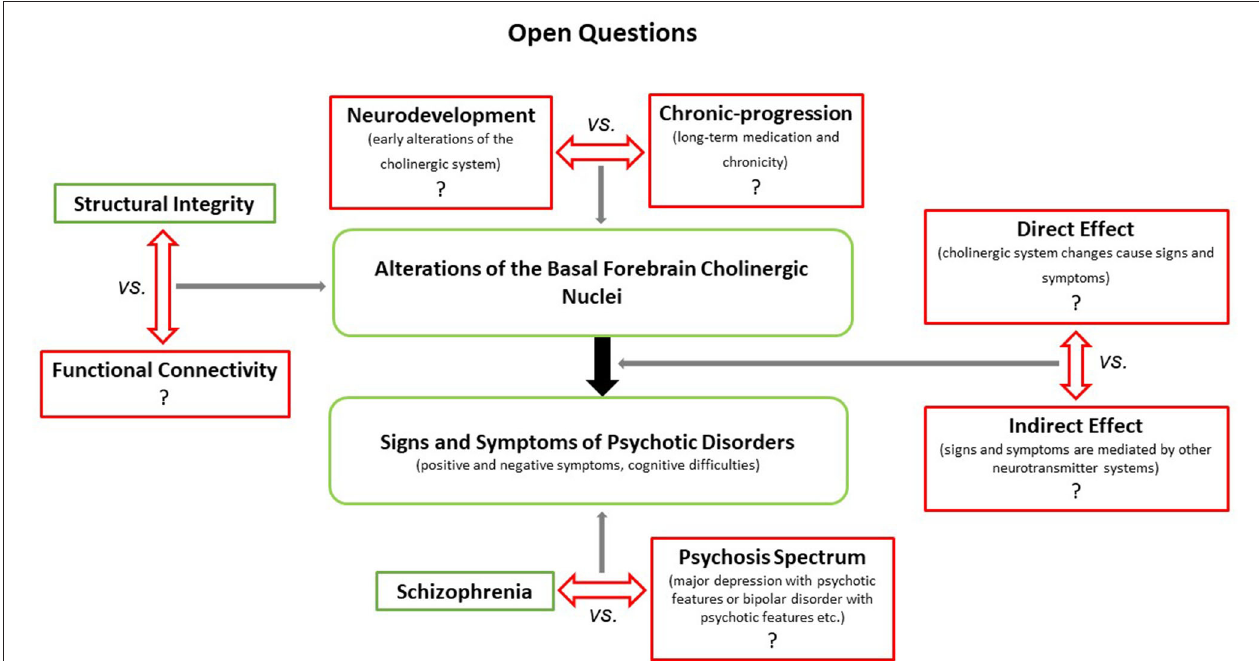
FIGURE 1 | Illustrates open questions concerning the putative role(s) of the BFCN in the generation and maintenance of distinct symptoms in schizophrenia and other psychotic disorders. First, it remains to be determined whether the apparent structural (and potentially functional) changes of the BFCN in patients with schizophrenia reflect effects of neurodevelopmental or chronic-progressive processes. Second, it is unclear whether BFCN alterations induce/maintain symptoms directly (e.g., via attenuated cholinergic transmission) or indirectly (e.g., via interactions with the dopaminergic system). Finally, while recent imaging studies have shown that cholinergic transmission is altered in other psychotic disorders beyond schizophrenia ( 67), it is unclear whether BFCN alterations are schizophrenia specific or rather ubiquitous across psychotic